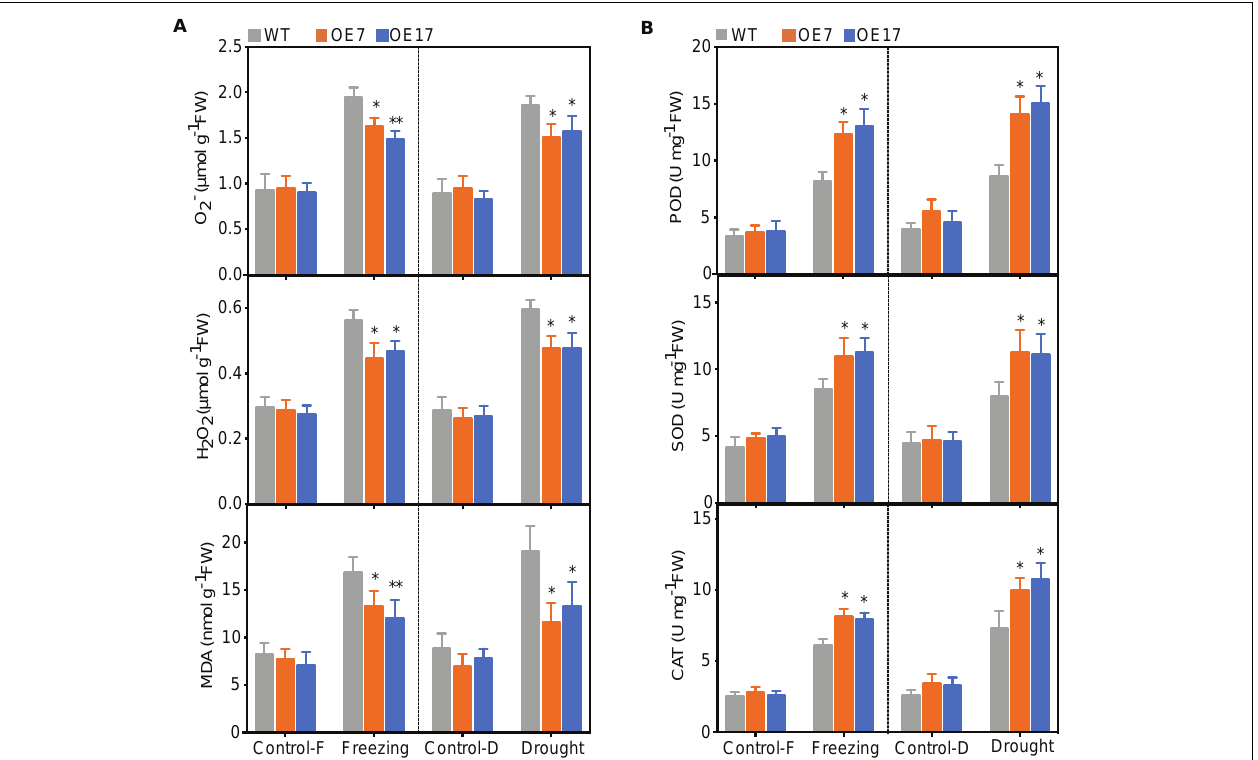
FIGURE 7 | Analysis of reactive oxygen species (ROS) accumulation and scavenging systems. (A) Analysis of reactive oxygen species (ROS) accumulation and malondialdehyde (MDA) content in WT and transgenic lines under freezing and drought conditions. (B) Activities of peroxidase (POD), superoxide dismutase (SOD), and catalase (CAT) in WT and transgenic lines under freezing and drought conditions. Four-week-old tobacco plants were subjected to freezing (–2 ◦ C for 8 h) and drought (withholding water for 8 days) stress. Tobacco leaves were collected for analysis. Control-F, control in freezing treatment, Control-D, control in drought treatment. Data are means ( ± SD) calculated from three replicates. Asterisks indicate significant difference between the WT and the two transgenic lines ( ∗ P < 0.05, ∗∗ P < 0.01, by two-way ANOVA Tukey test). Three biological experiments were performed, which produced similar results.